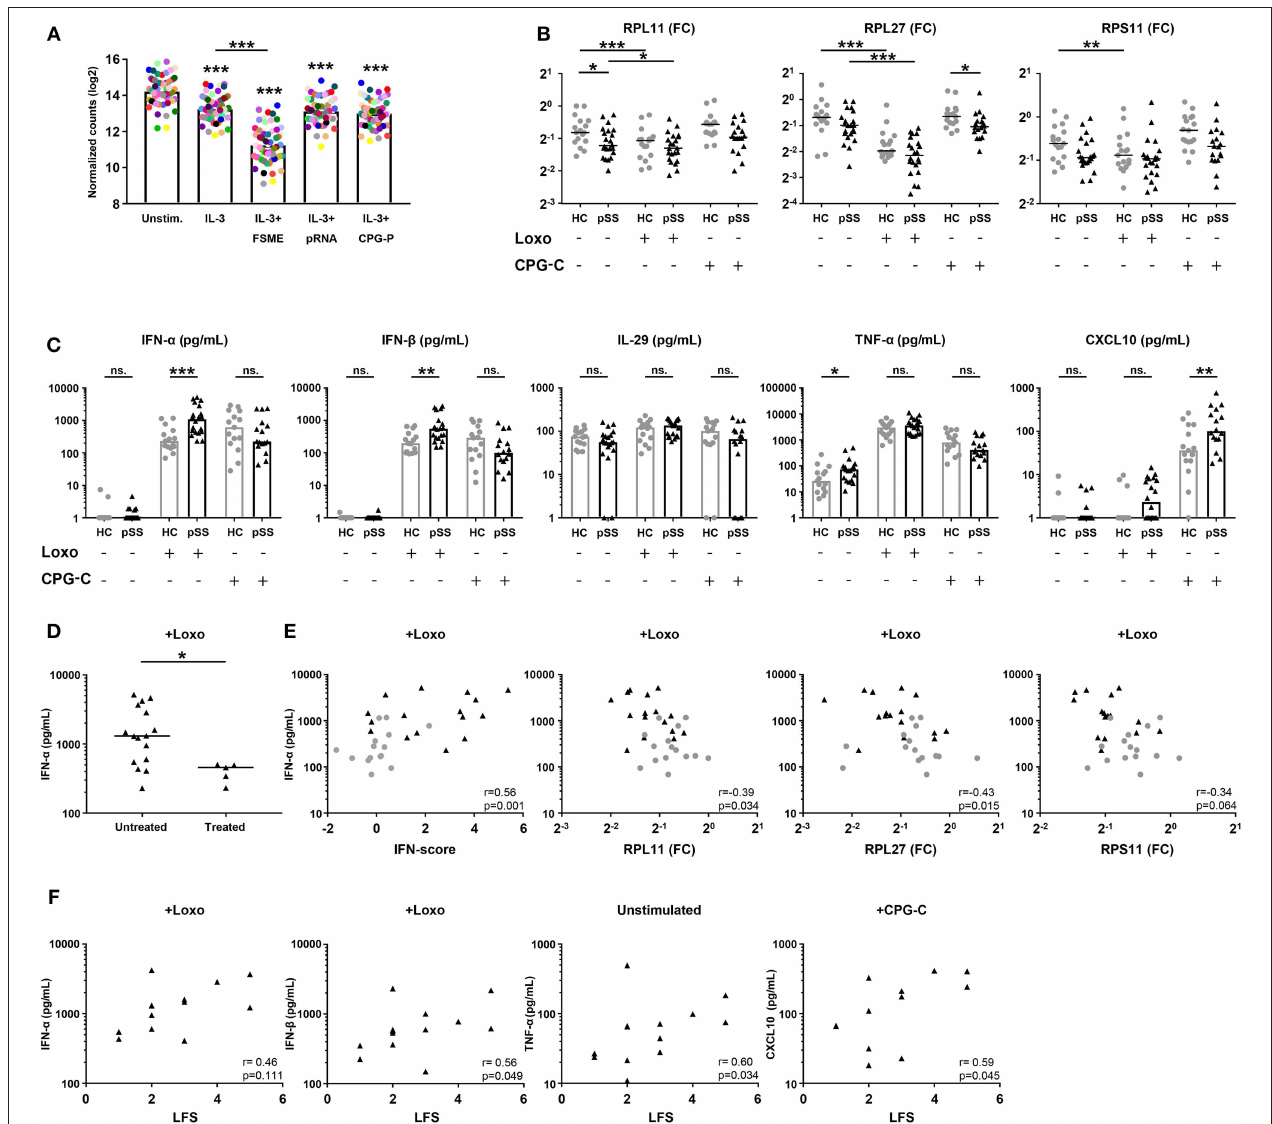
FIGURE 5 | pSS pDCs produce more pro-inflammatory cytokines upon stimulation, associated with expression of hub-genes from the red and blue signatures. Publically available RNA-sequencing data [29] of TLR ligand-stimulated HC pDCs purified from peripheral blood were used to evaluate the effect of pDC activation on ribosomal protein gene-expression. pDCs were stimulated for 6h in the presence of IL-3 as a survival factor and/or various TLR ligands. Each colored dot represents one specific RP gene, median expression in n = 3 donors was plotted for each condition (A) . pDCs were purified from peripheral blood of pSS ( n = 22) and HC ( n = 17) donors and cultured for 3h in medium or in the presence of 1mM loxoribine (Loxo; TLR7L) or 1 µ M CPG-C (TLR9L). Supernatants were harvested and cells lysed for mRNA quantification using qPCR. Changes in expression of three major hub-genes from the blue signature were assessed upon stimulation (B) . Differences in cytokine secretion between pSS and HC were quantified using luminex (C) . Production of IFN- α upon stimulation with loxoribine was compared between patients who were treated with immune-suppressive treatment (treated) and those who were not (D) . IFN- α production upon Loxo stimulation in the untreated donors was correlated with the IFN-score, calculated as the mean Z-score of the five quantified IFN-induced genes as compared to HC donors measured in PBMCs, as well as the expression of RPL11 , RPL27, and RPS11 measured in the unstimulated condition (E) . The association of cytokine production with salivary gland inflammation (measured using the lymphocytic focus score/LFS, which represents the number of lymphocytic aggregates per 4 mm 2 tissue) in untreated pSS patients was assessed (F) . *, ** and *** represent p < 0.05, p < 0.01, and p < 0.001,